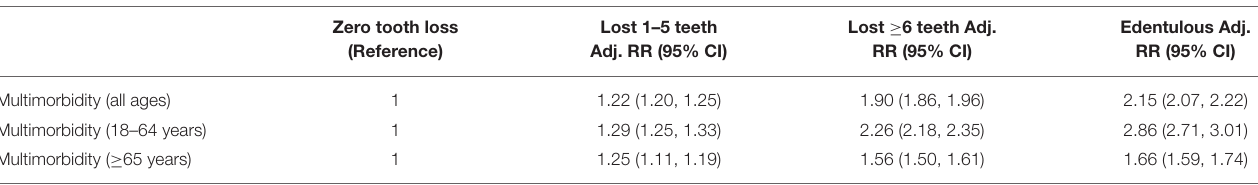
TABLE 4 | Association between multimorbidity and tooth loss by age group a